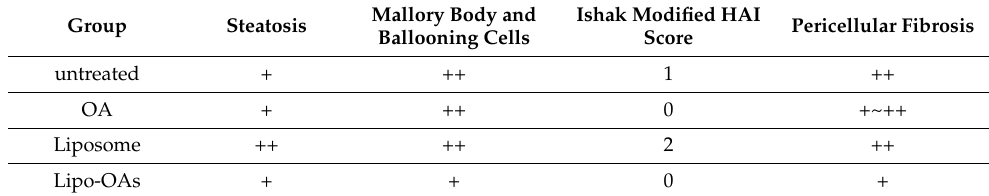
Table 2. Histological findings and scores after 6 treatment weeks in PM 2.5 -induced inflammation liver. Group Steatosis